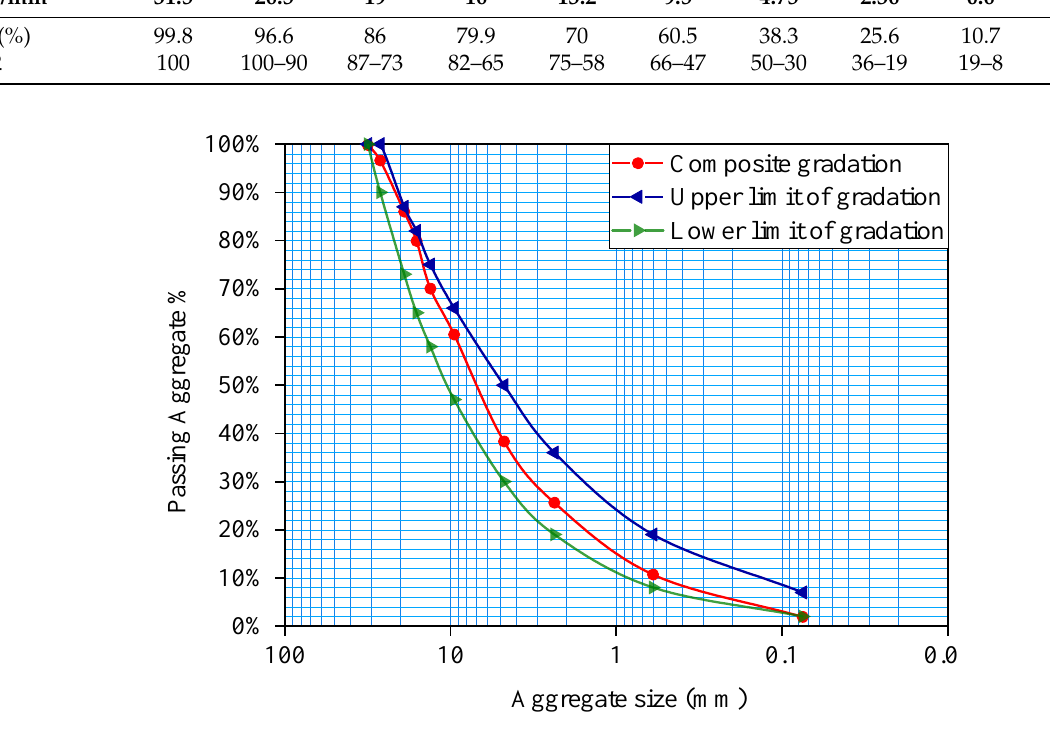
( b ) Crushed stone Figure 15. Test results of compaction test of mixture. 4.3. 7-Day Unconfined Compressive Strength The representative value of 7-day unconfined compressive strength of cement sta- bilized macadam with 4% cement content was R d = 4.0 MPa. The representative values of